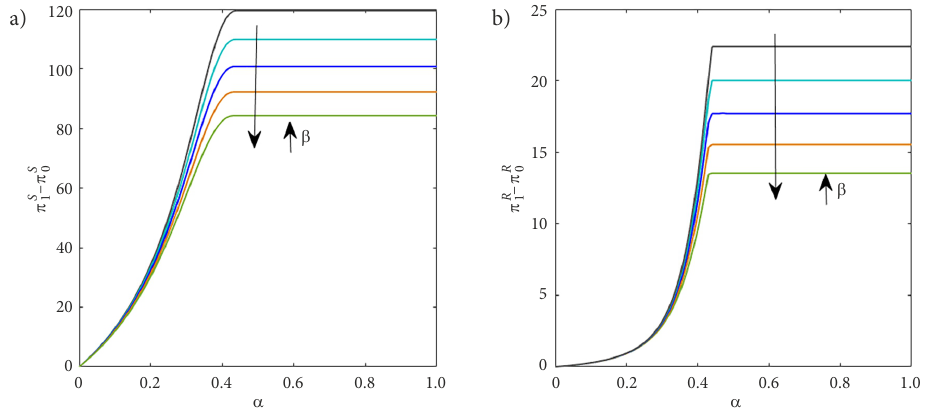
Figure 4. Impact of bankruptcy costs for any division of